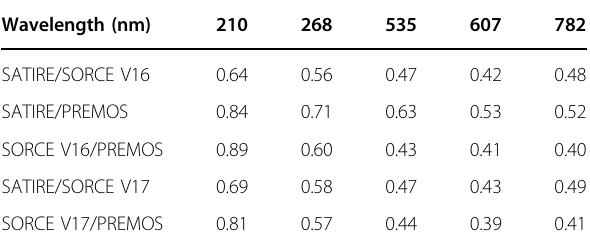
Table 2 Correlation coef fi cients between the SATIRE, SORCE-V16, SORCE-V17 and PREMOS during the